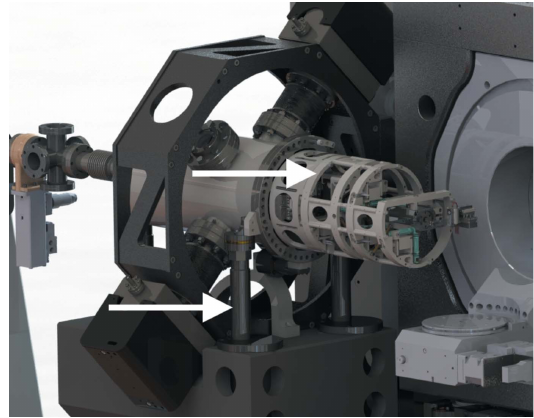
Figure 3 A 3D rendering of the KB mirror system, the body of the chamber partly hidden for visibility of the internal parts. The two arrows indicate, from left to right, one supporting leg and the light cage hosting the mirrors. In operation conditions, the whole system is under vacuum.